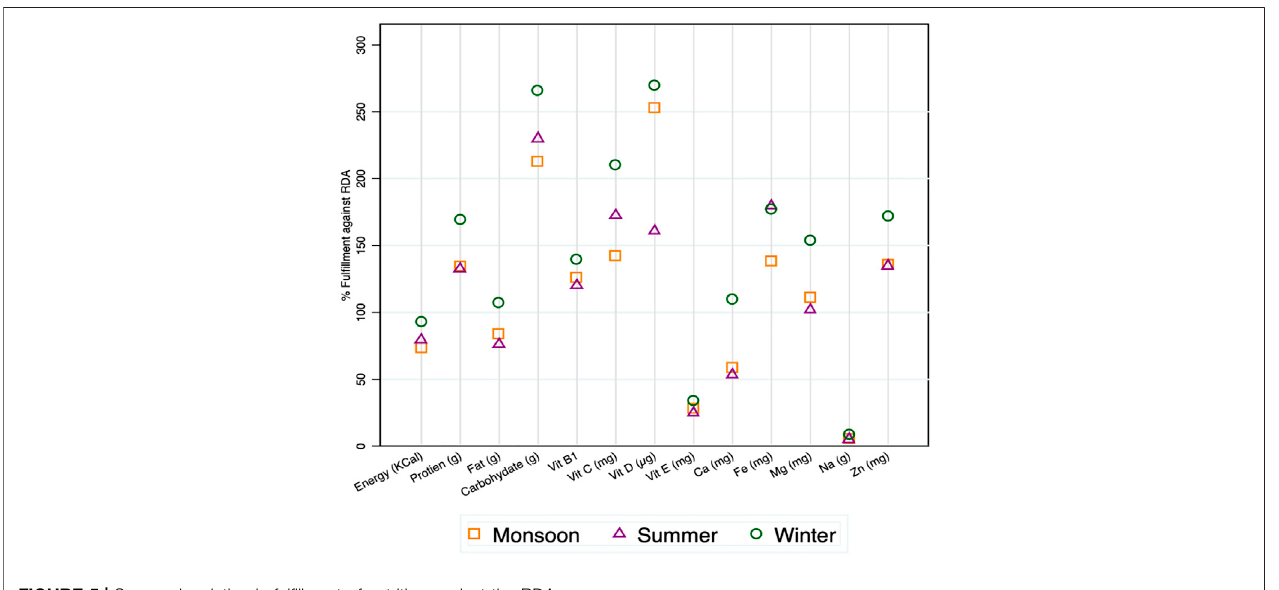
FIGURE 5 | Seasonal variation in ful fi llment of nutrition against the RDA.